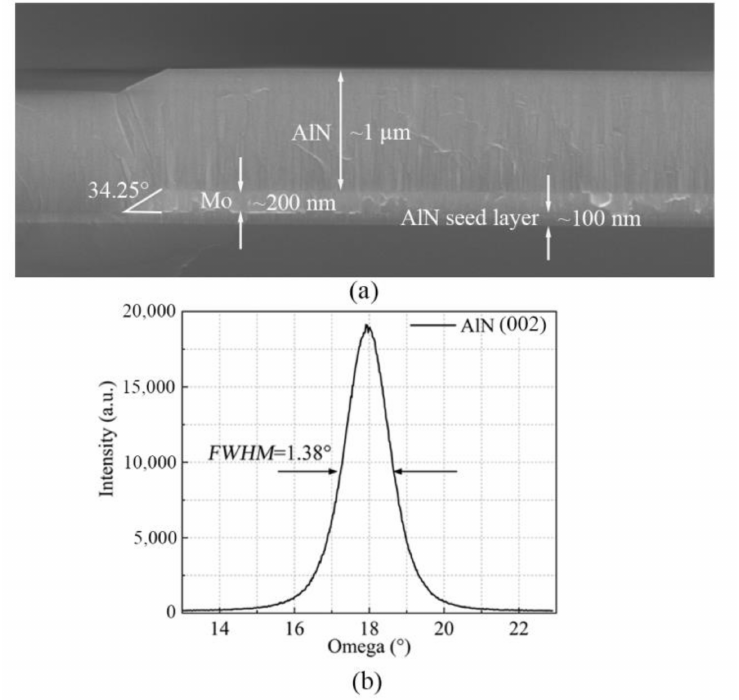
Figure 4. ( a ) SEM images of the cross section of the Mo sidewall; ( b ) XRD rocking curve of the 1- µ m-thick AlN (002) layer. Ti (20 nm)/Al (180 nm) layers and then Ti (20 nm)/Al (1 µ m) layers were